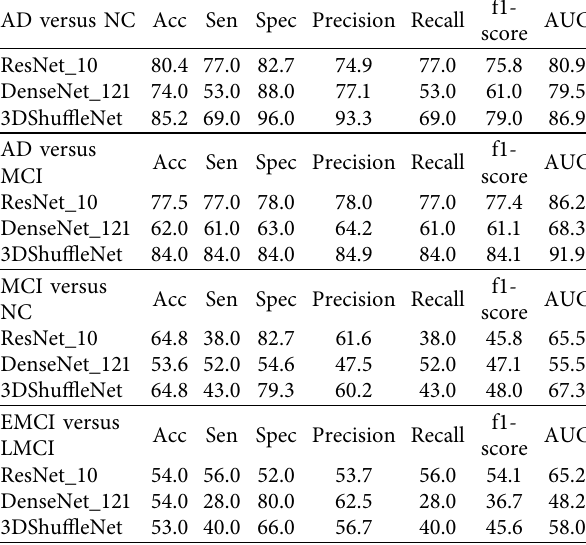
Table 2: Experimental results of sMRI data (%). AD versus NC Acc Sen Spec Precision Recall